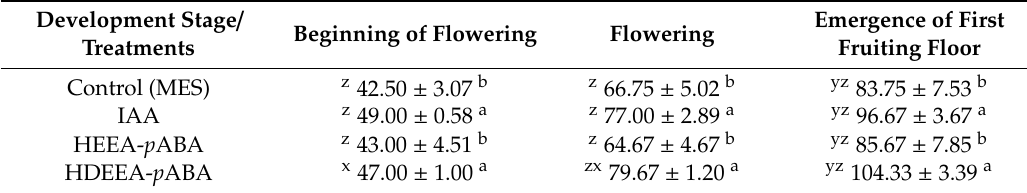
Table 5. The treatments e ff ect on height (cm) of tomato plants (cv. Tomtim) in di ff erent stages of